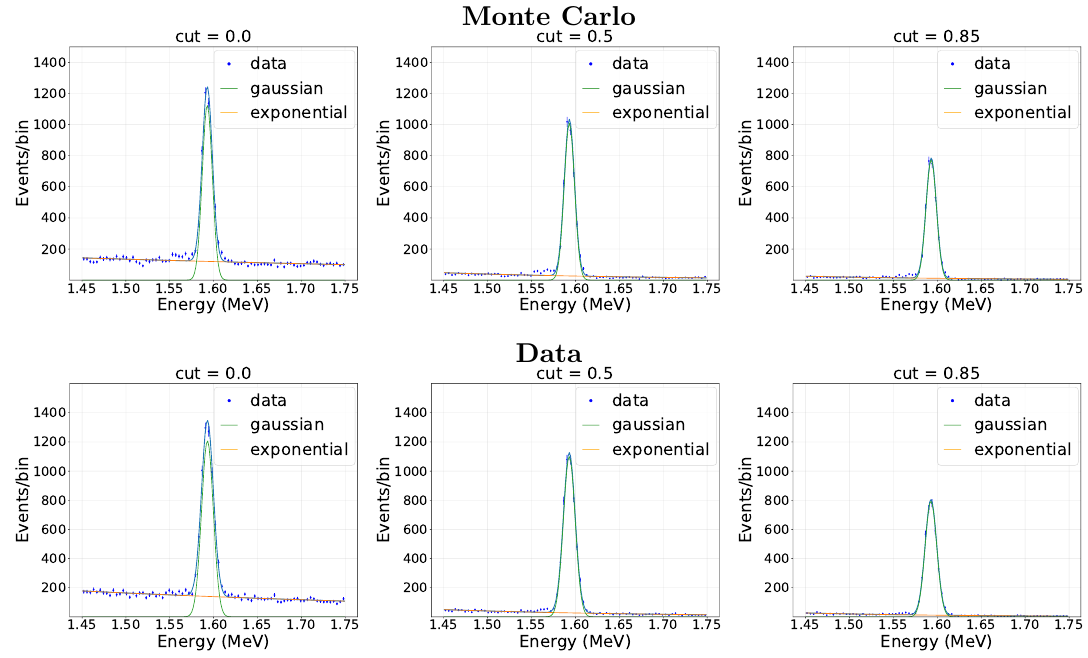
Figure 9 . Fits of the energy spectra of Monte Carlo simulation (top) and data (bottom) near the double-escape peak of 208 Tl at 1592 keV (see text for details). The fits are shown using events passing a neural network classification cut of 0.0 (to obtain the total number of signal and background events), 0.5 (the cut usually used in binary classification problems) and 0.85 (the cut that was found to yield the optimal